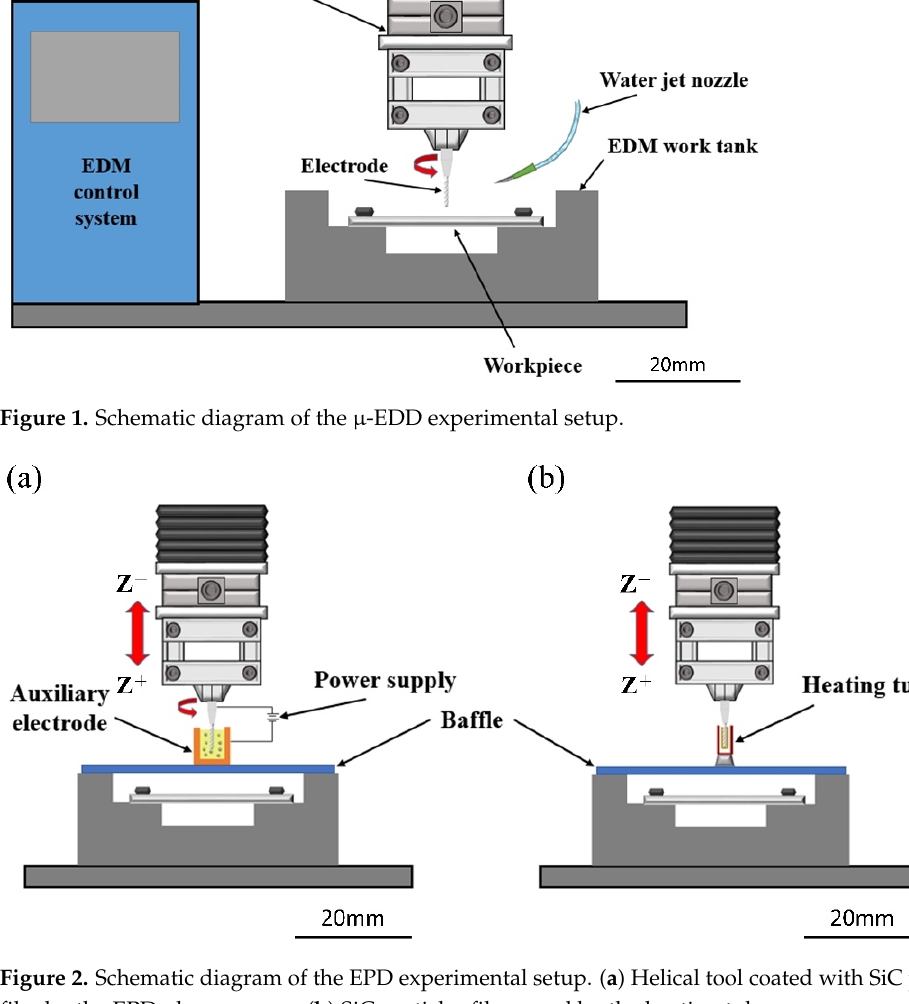
Figure 2. Schematic diagram of the EPD experimental setup. ( a ) Helical tool coated with SiC particle film by the EPD phenomenon. ( b ) SiC particles film cured by the heating tube.